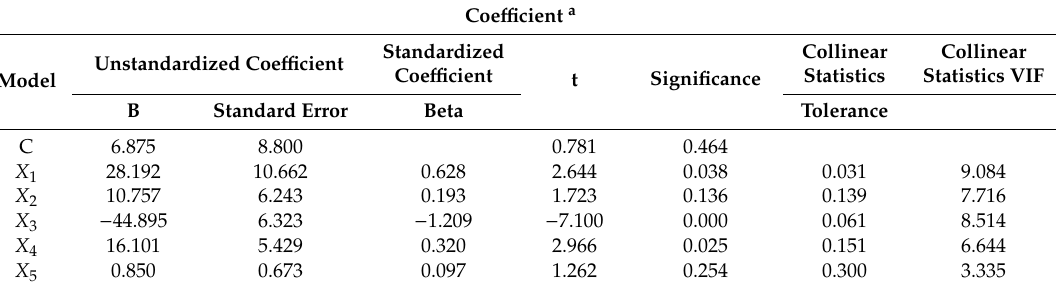
Table 2. Partial regression coe ffi cient